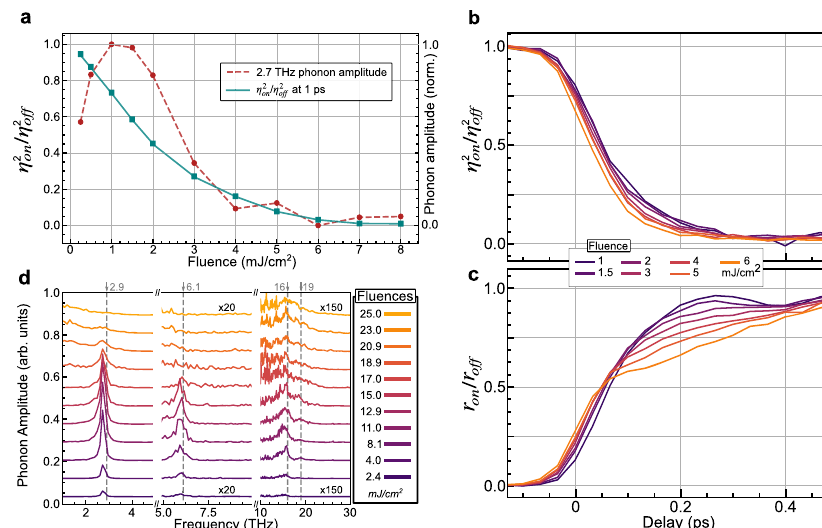
Fig. 4 Simultaneous excitation of multiple degrees of freedom in LSMO. a Fluence dependence of the order parameter and the amplitude of the 2.7 THz mode from r. The order parameter shows a monotonic decrease whereas the phonon amplitude fi rst rises before being suppression at the same fl uences as the order parameter. b Focused and normalized view of the fi rst 500 fs of ƞ 2 showing a marked speedup with increasing fl uence. c Same as b but for r . In contrast to ƞ 2 a slowdown is observed with increasing fl uence. d Few-cycle pump-probe measurements of phonon dynamics with 1800 pump and 650 nm probe pulses (see methods and Supplementary Fig. S5 for details). 2.7, 6, 16 and 19 THz modes of LSMO are clearly observed and in good agreement with the literature 33 (dashed lines). The 2.7 and 6 THz modes are suppressed as the system is pumped through the transition, while the high-frequency modes